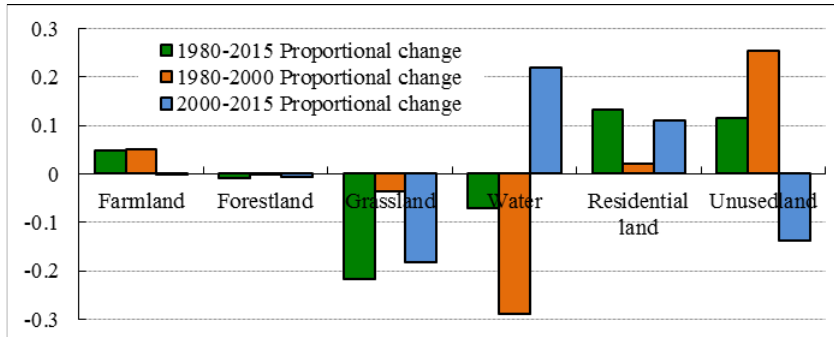
Fig.3 Changes in the Proportion of Land Use/Land Cover Types during Different Periods (%)